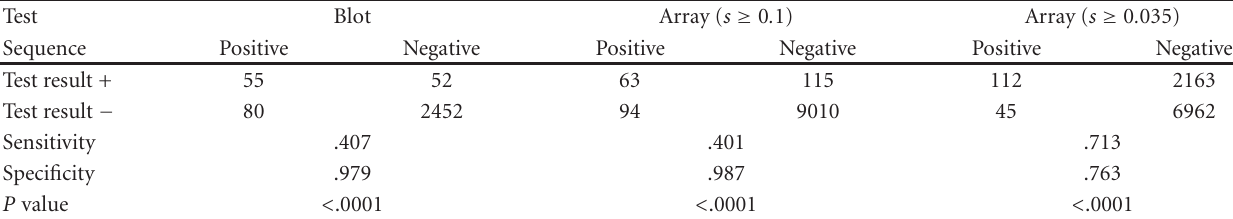
Table 1: Comparison of array performance to blot. P values: Fisher’s exact test.